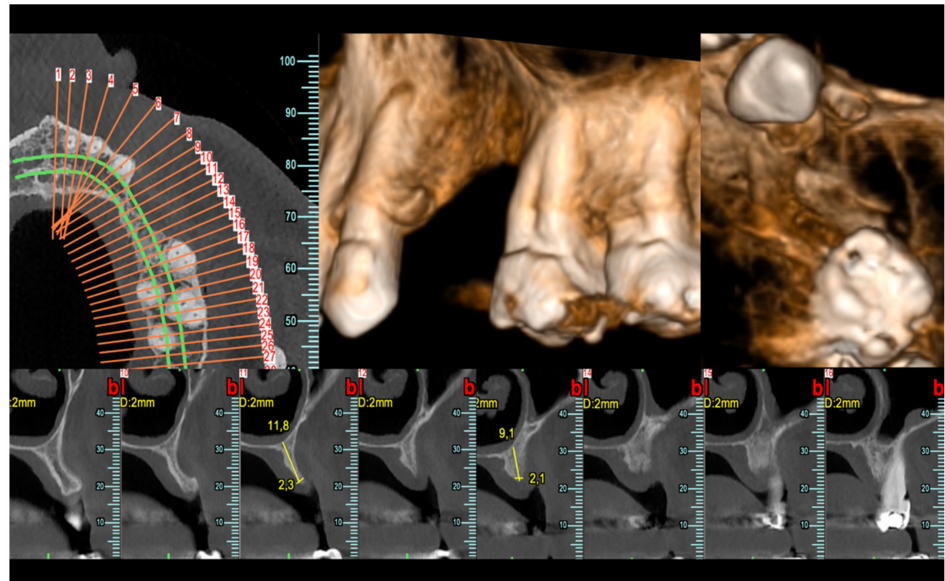
Figure 1. CBCT showing the severely resorbed area of 24–25 and the advanced bone loss at the mesial aspect of 26.